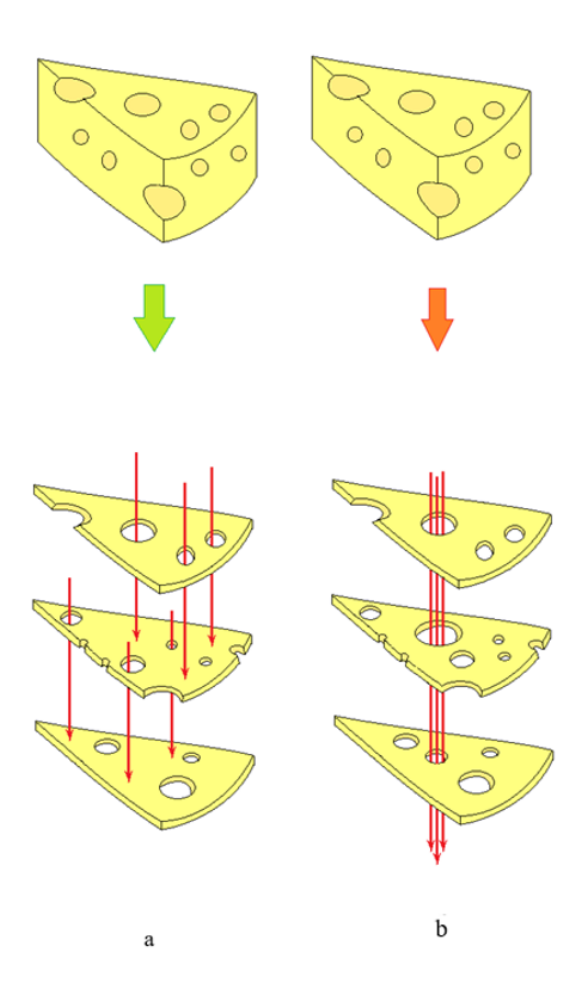
Fig. 2. Model «Cheese holes»: a – «overlapping holes with layers of cheese»; b – «overlapping